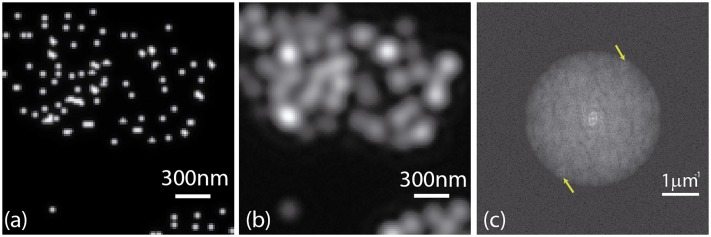
Simulation of a structured illumination microscope imaging process.(a) Synthetic object consisting of a cluster of beads of size 5 times smaller than the wide-fiield point spread function. (b) Simulated image intensity distribution of an elementary image of the synthetic object and (c) its corresponding Fourier transform (modulus). The arrows show the position of the peak of the SI components.